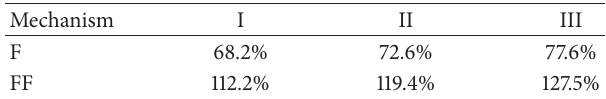
Table 1: Surface coverage of silica nanoparticles according to different reaction mechanisms as calculated from